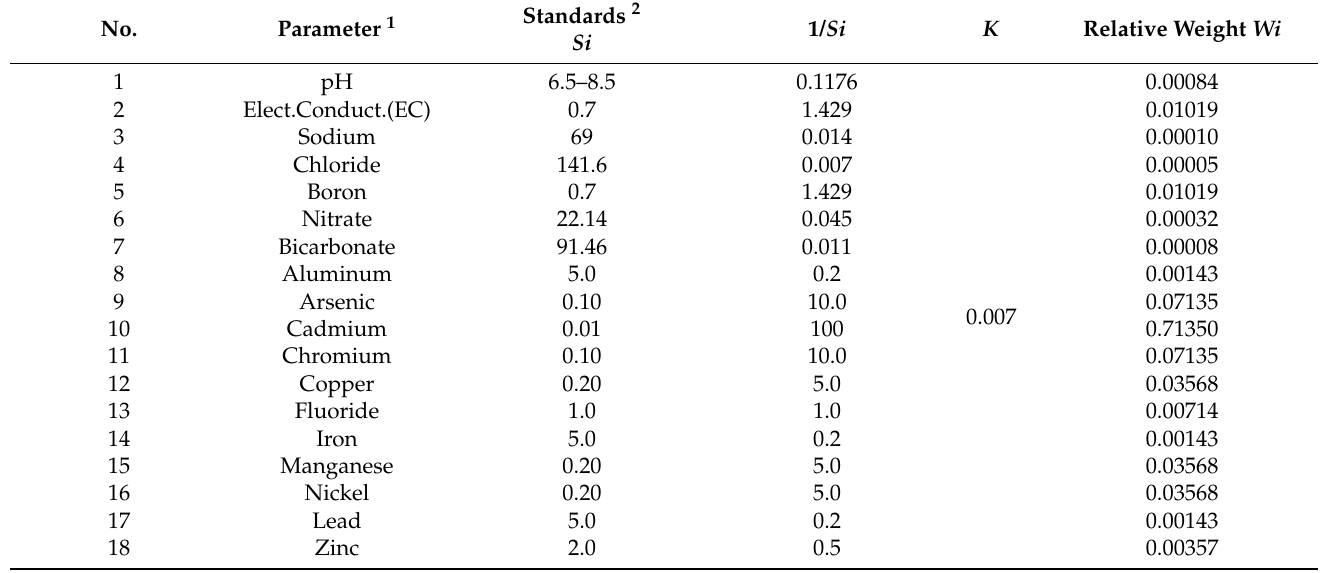
Table 2. Standards for irrigation water and relative weight of